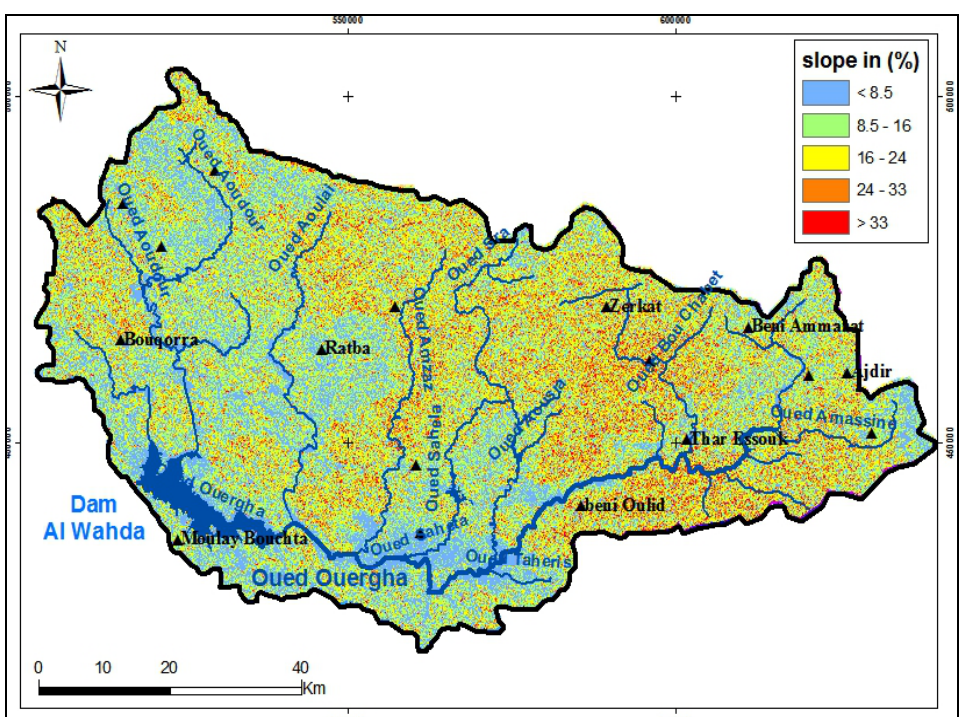
Figure 4 . Map of the slopes of the Ouergha